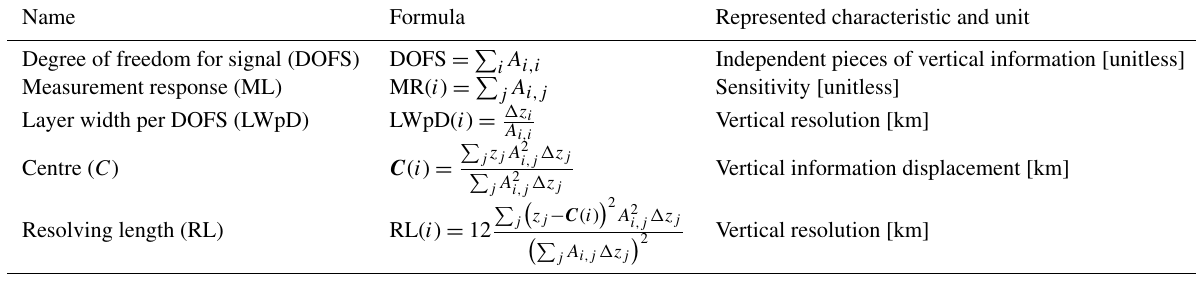
Table 2. Metrics for sensitivity and resolution calculated from the elements of the averaging kernel matrix ( A i,j ). Name